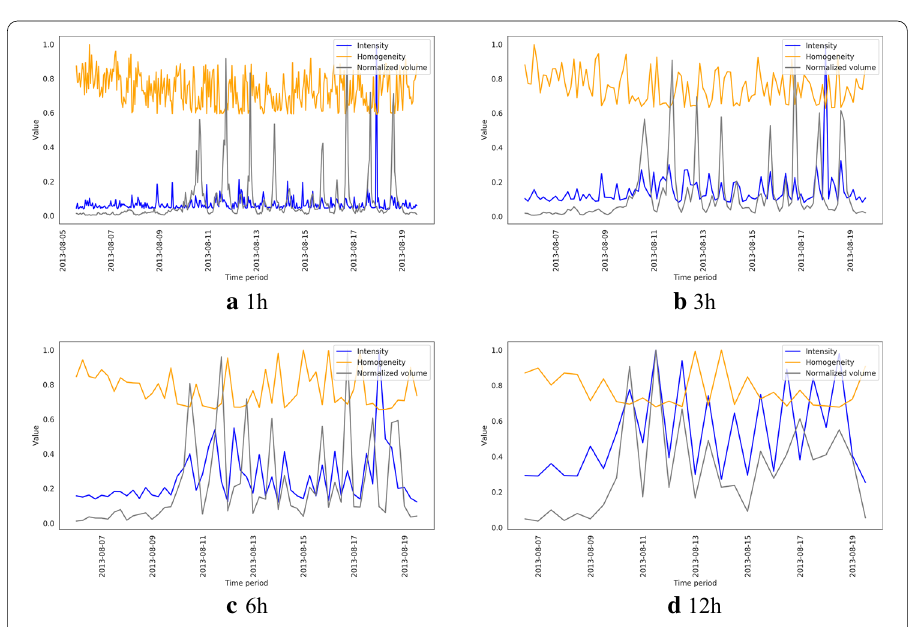
Fig. 26 Different sizes of time windows for the MoscowAthletics2013 data